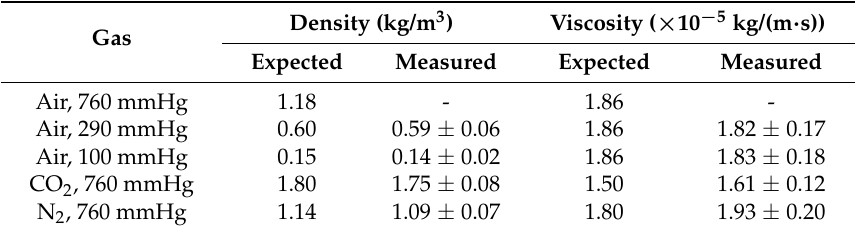
Figure 5. ( a ) Amplitude and phase of the transfer function for the nanoscale-thickness cantilevers under the fluid-structure interaction in air (760 mmHg, 290 mmHg, and 100 mmHg), carbon dioxide (760 mmHg), and nitrogen (760 mmHg), with their predicted values; ( b ) Measured density and viscosity of the gases at different frequencies. Table 1. Mean values and standard deviations of the measured densities and viscosities of the gases at 27 °C and their comparison to the typical values from the literature [17,18].